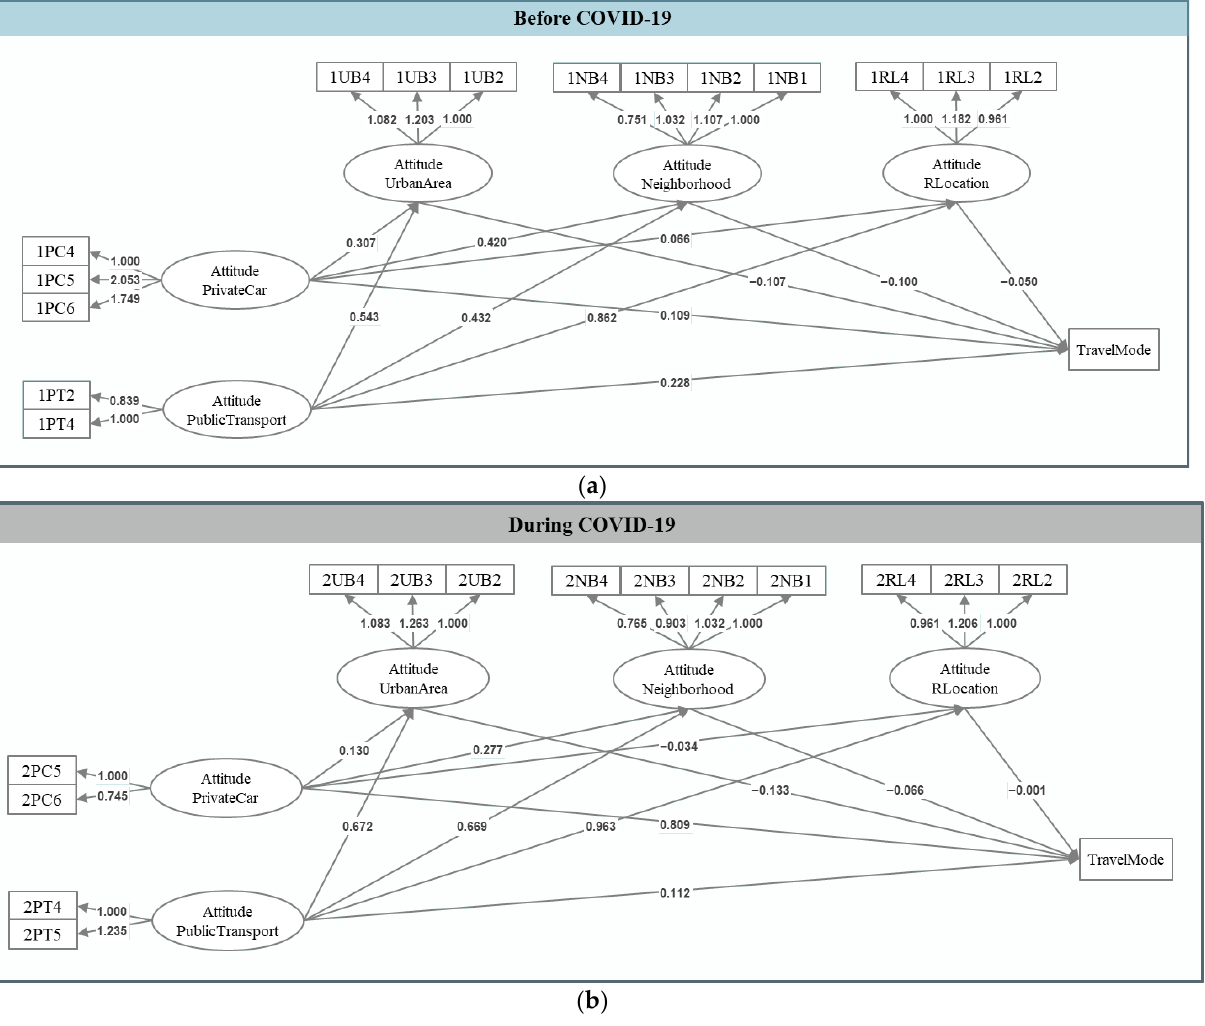
Figure 4. Structural model of study for ( a ) before COVID-19 model; ( b ) during COVID-19 model.